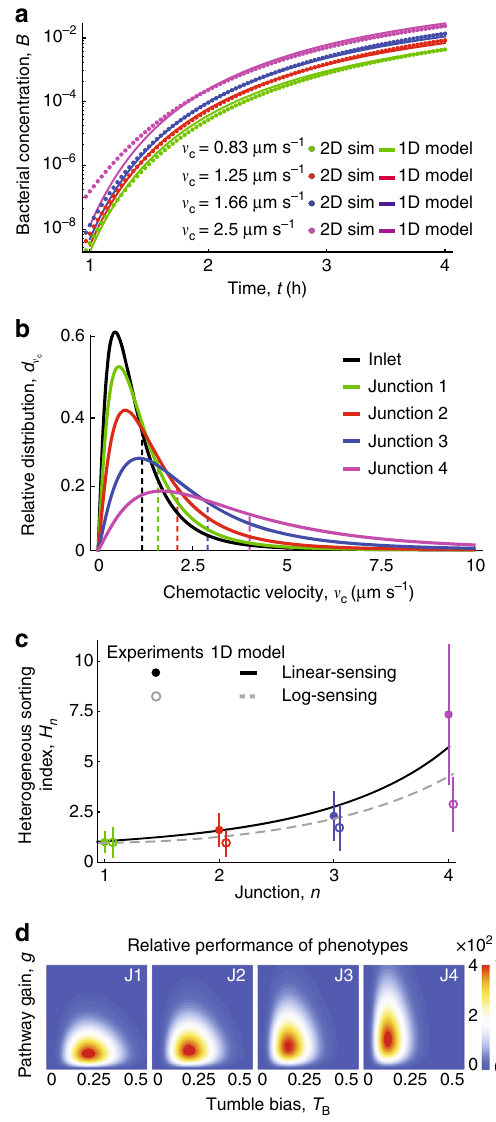
Fig. 5 Cell sorting of a chemotactically heterogeneous population of bacterial cells. a Predictions from a 1-D advection-diffusion model at junction four (lines) match the results from 2-D simulations based on the actual maze geometry (circles), for four values of chemotactic velocity within the expected range for E . coli (0.8 – 2.5 µ m s − 1 ). b Based on the analytical model of chemotactic heterogeneity, the relative distribution of chemotactic velocities in a heterogeneous population of cells shifts to higher values in consecutive junctions of the maze. Dashed vertical lines show the mean of each distribution. c The heterogeneous sorting index is the ratio of the expected number of cells at each junction from a heterogeneous population compared to those from a homogeneous population with the same initial mean chemotactic velocity. Filled circles show the mean H n over the three experimental replicates for the linear-sensing regime (0 – 5 μ M) and open circles for the log-sensing regime (0 – 500 μ M). Error bars are ± s.d. over the three experimental replicates. The solid black and dashed gray lines are the predictions from the 1-D advection-diffusion model for the linear-sensing and log-sensing regimes, respectively. d Relative performance of phenotypes (from lower performance in blue to high performance in red) as a function of pathway gain and tumble bias for a monoclonal population of cells reaching each junction in the T-maze (junctions 1 – 4 from left to right) NATURE COMMUNICATIONS| (2019) 10:1877